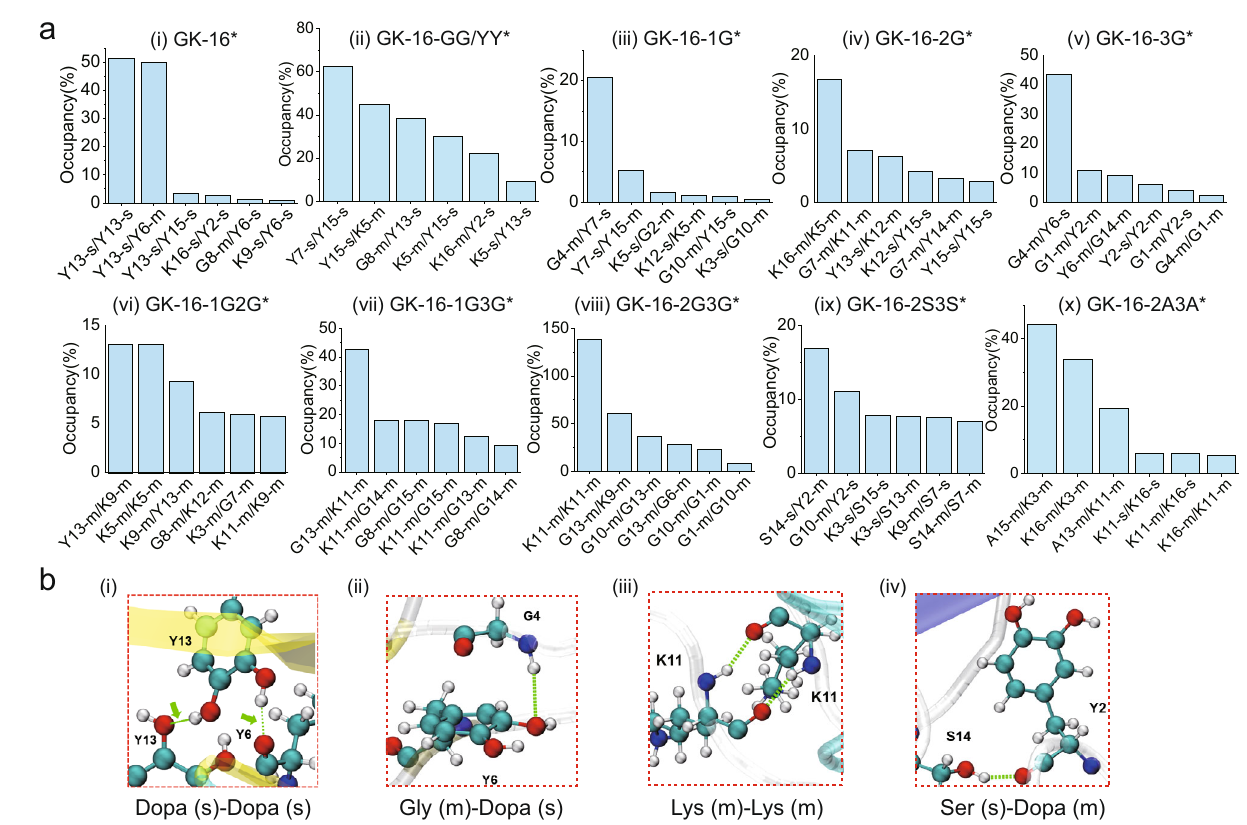
Fig. 5 | H-bond formations between pairs of GK-16* and its variants in MD simulations. a The representative occupancy of most probable H-bond betweendifferentresidueswasobtainedfromthelast40nsofsimulations(the associated pairs) of (i) GK-16*; (ii) GK-16-GG/YY*; (iii) GK-16-1G*; (iv) GK-16-2G*; (v) GK-16-3G*; (vi) GK-16-1G2G*; (vii) GK-16-1G3G*; (viii) GK-16-2G3G*; (ix) GK- 16-2S3S*; (x) GK-16-2A3A*. The occupancy representing the overall H-bond